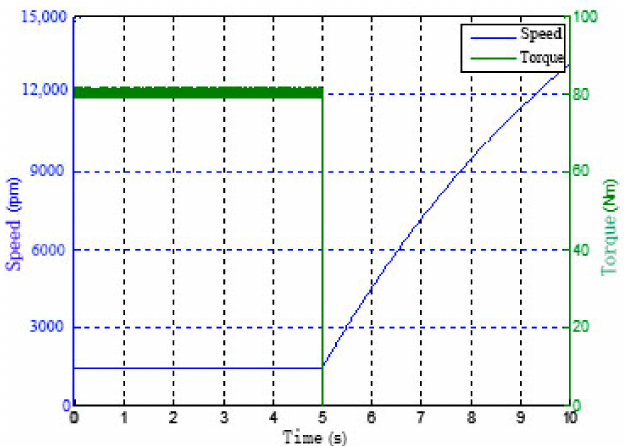
Figure 17. Stalling process with heavy